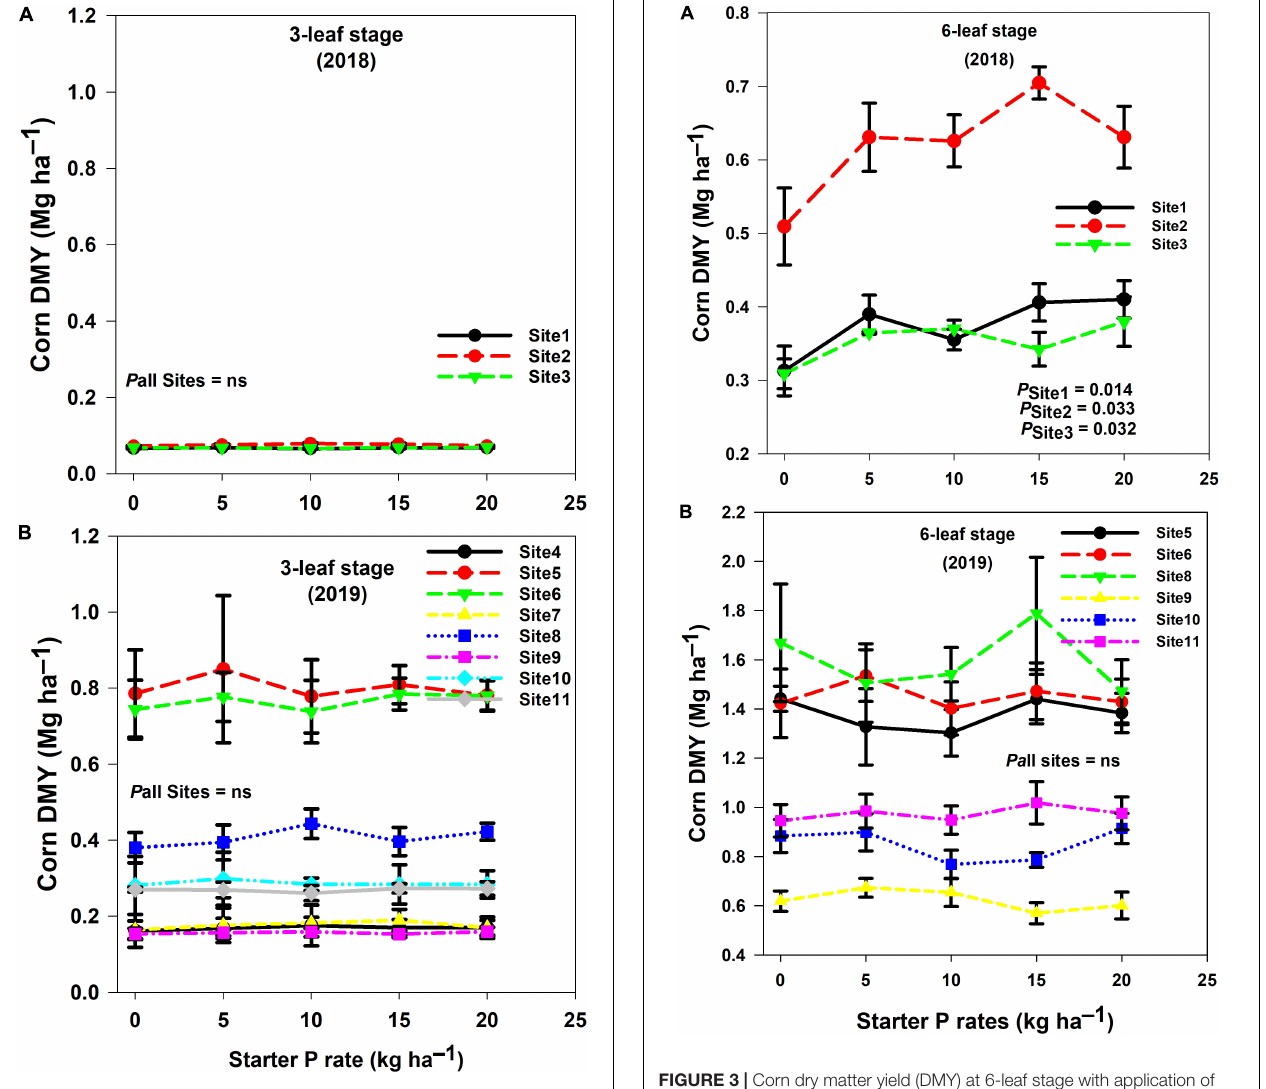
FIGURE 2 | Corn dry matter yield (DMY) at 3-leaf stage with application of starter P rates across 11 sites [2018 (A) and 2019 (B) ] in the Fraser Valley, BC. Error bars represent standard deviations of the means.